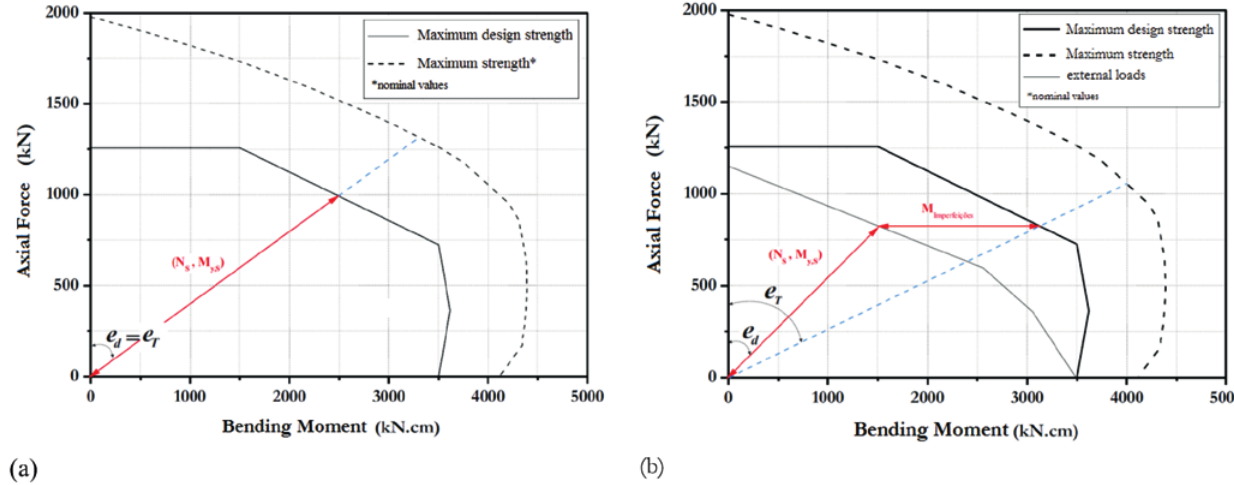
Figure 5 Analysis strategies A) – without – and B) with – consideration of additional eccentricity due to column